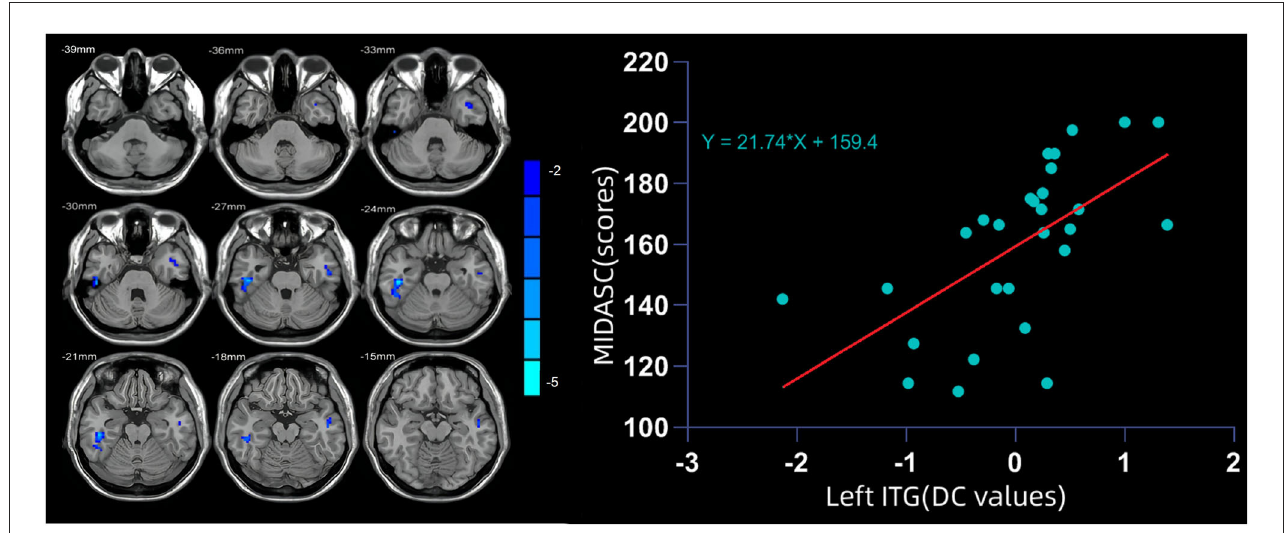
TABLE 2 Alterations of DC between patients and controls. Cluster location Peak (MNI) Number of voxels T -value X Y Z − 54 Right ITG